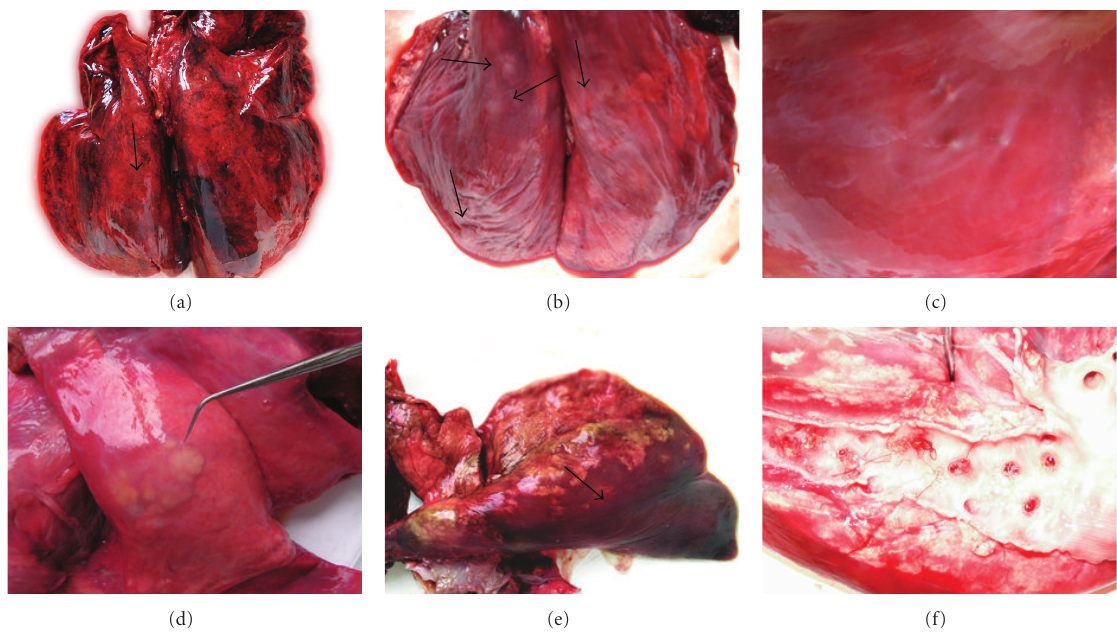
Figure 1: Lungs of ruminants infected with protostrongylids. (a) Mouflon, lungs, M. capillaris infection, dark-grey to black, congested areas, (b) Mouflon, lungs, M. capillaris infection. Well-formed, firm, grey nodules, (c) Mouflon, lung, M. capillaris infection. Small, hard nodules (1–5 mm) under the lung pleura, (d) Sheep, lung, C. ocreatus infection, Slightly prominent, well di ff erentiated from the surrounding tissue area, (e) Goat, right lung, P. rufescens infection, dark-red to grey, congested area, (f) Goat, lung, P. rufescens infection, adult worms in